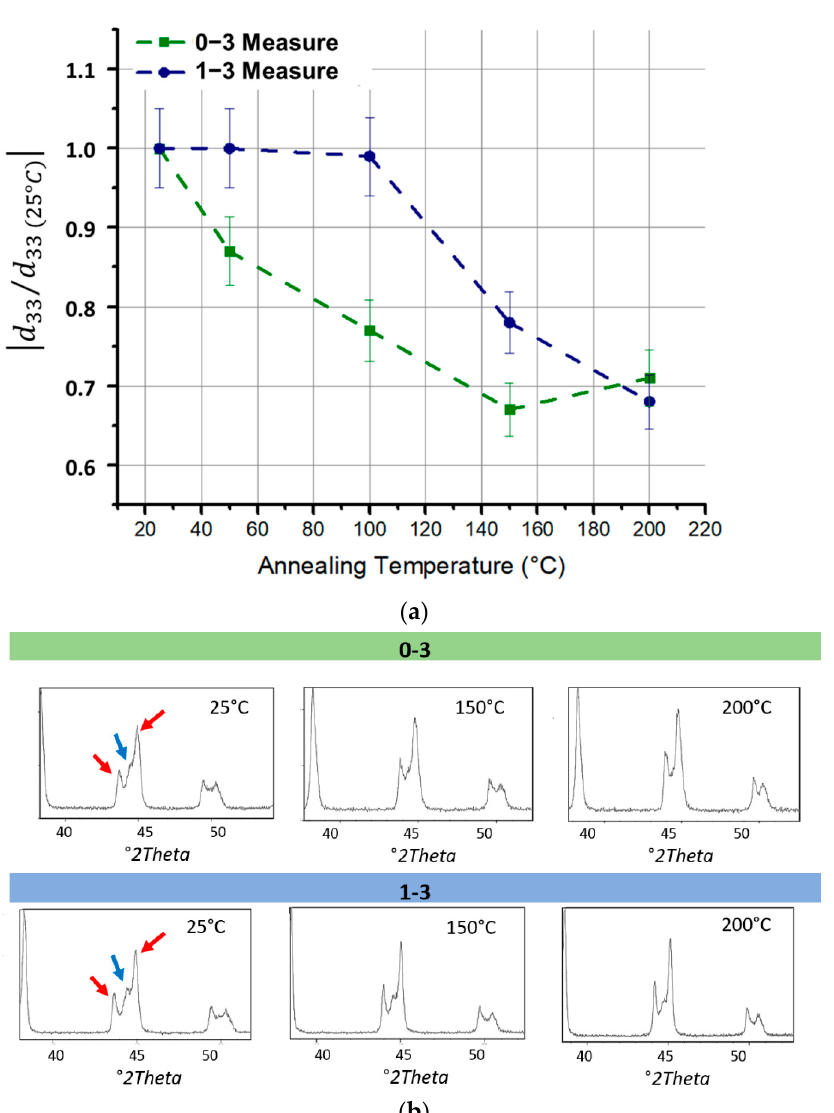
Figure 6. ( a ) Piezoelectric charge coefficient variation with annealing temperature of 0–3 and 1–3 PZT/PDMS 24%vol. The value is normalized with respect to the value at 25 °C. ( b ) X-Ray diffraction of 0–3 and 1–3 PZT/PDMS 24%vol at 25 °C, 150 °C and 200 °C. The red arrows indicate the tetragonal ferroelectric phase, while the blue one the rhombohedral phase.